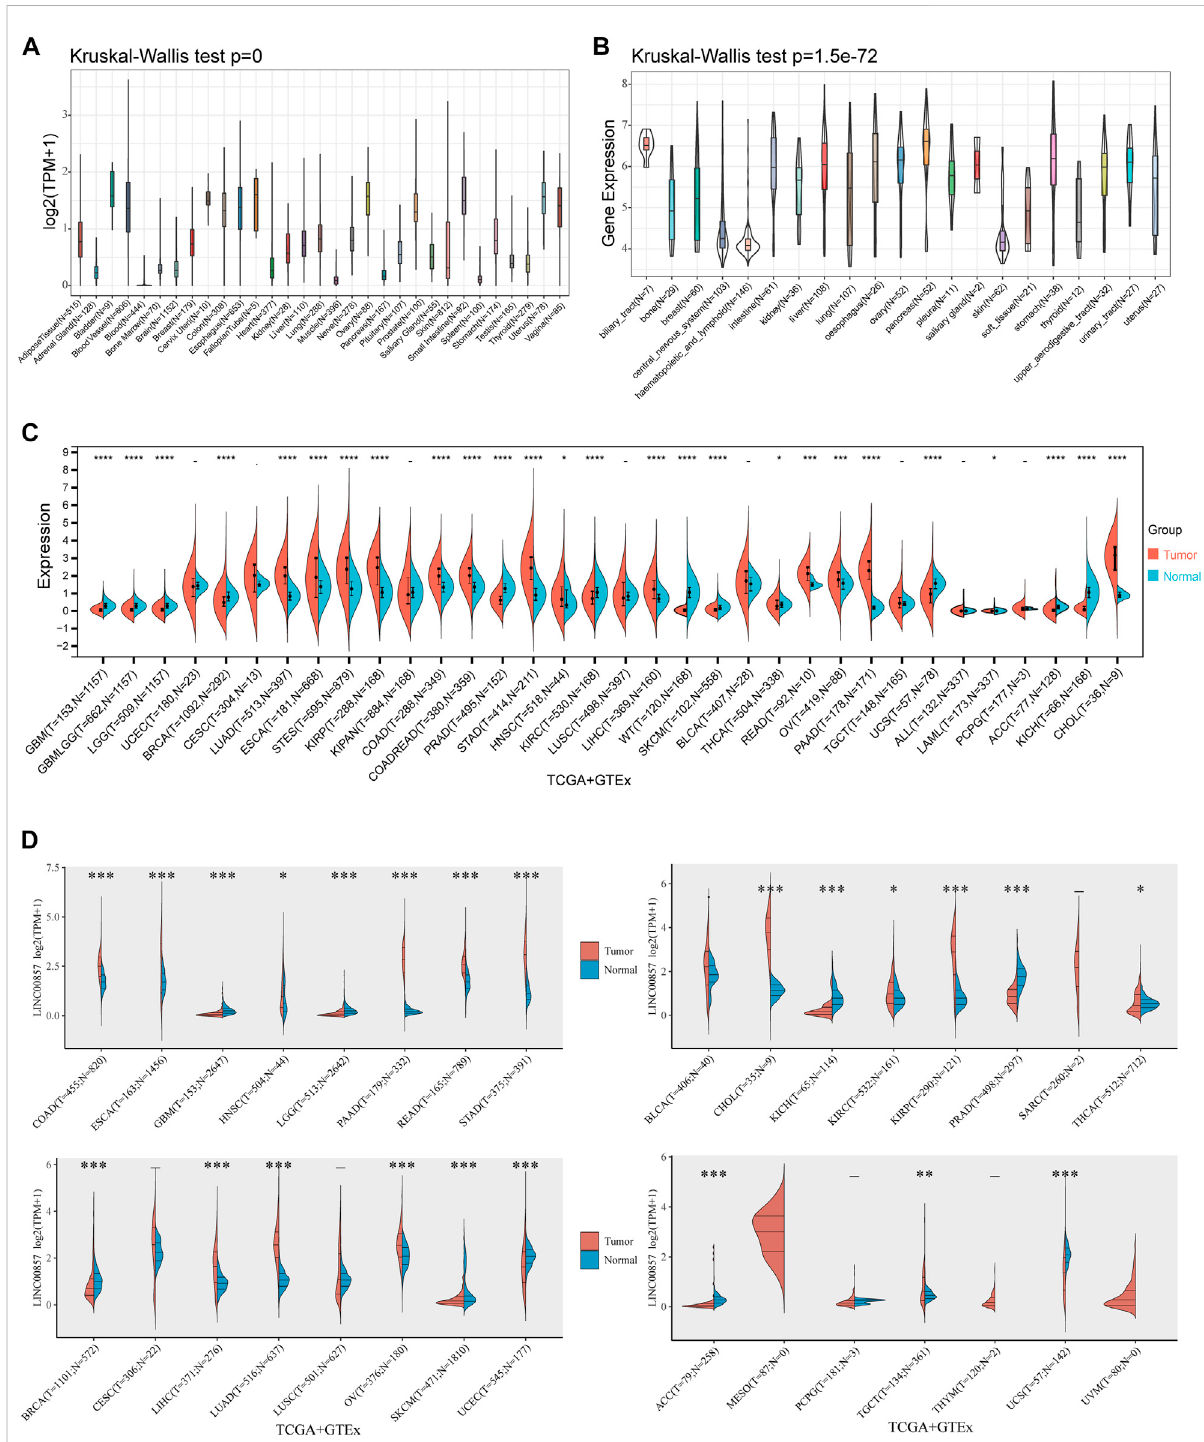
The expression levels of LINC00857 in pan-cancer. (A) LINC00857 expression in 31 human normal tissues from GTEx database. (B) LINC00857 expression in various cancer cell lines from CCLE database. (C) The expression levels of LINC00857 in different cancers and adjacent normal tissues were explored through Sangerbox 3.0 database. (D) The expression levels of LINC00857 in cancers or paired normal tissues were analyzed via online website ACLBI (* p < 0.05, ** p < 0.01, *** p <